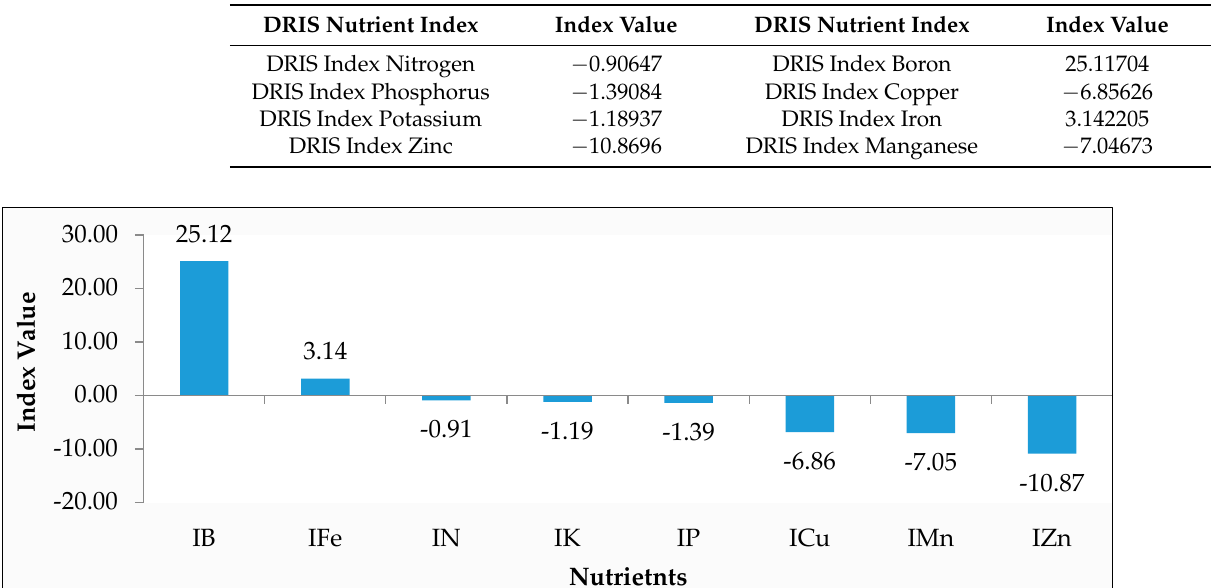
Table 1. DRIS nutrient index values according to Wadt methodology.